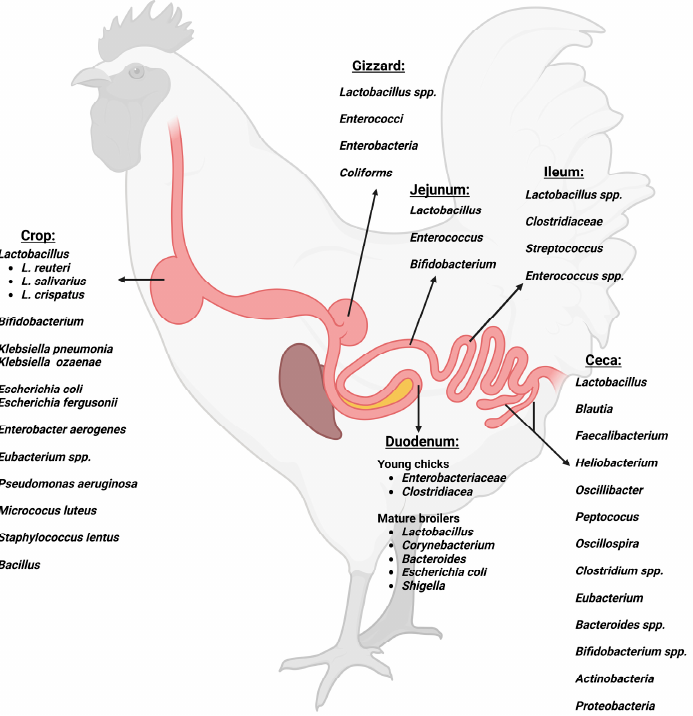
Figure 1. Major bacterial communities along the gastrointestinal tract of broilers. Created with BioRender.com (accessed on 29 January